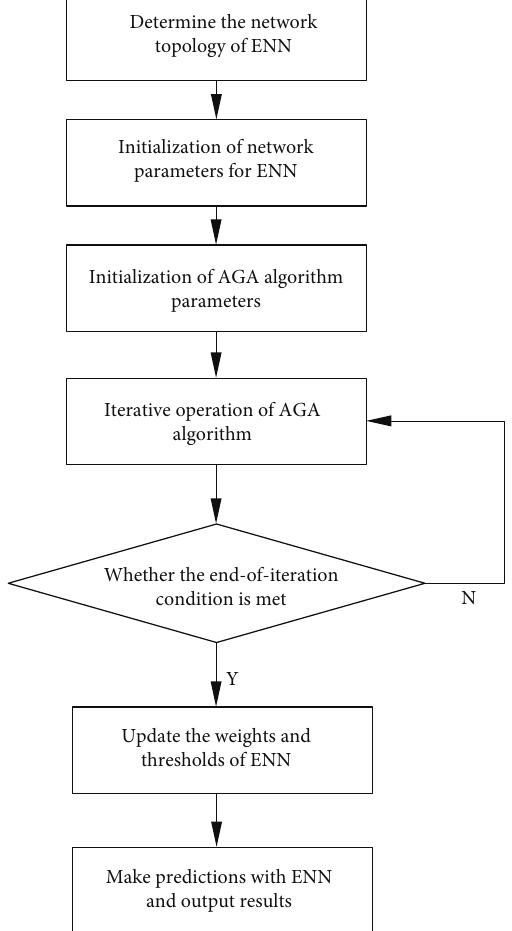
Figure 4: The fl ow chart of the AGA-ENN